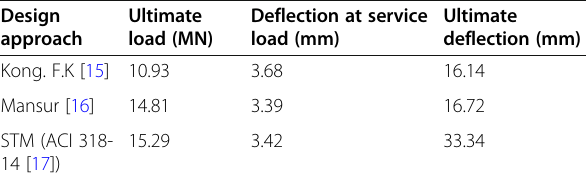
Table 4 Results from the numerical models Design